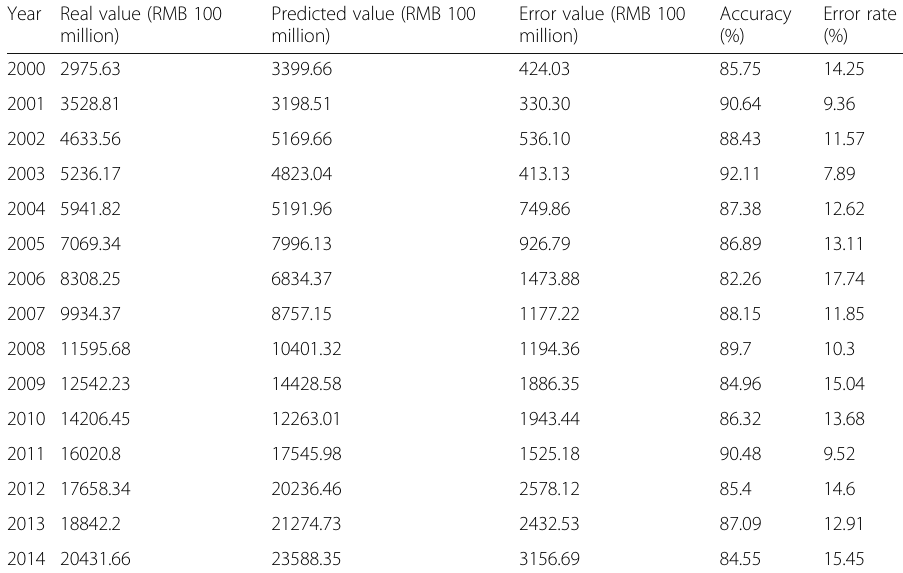
Table 1 The prediction